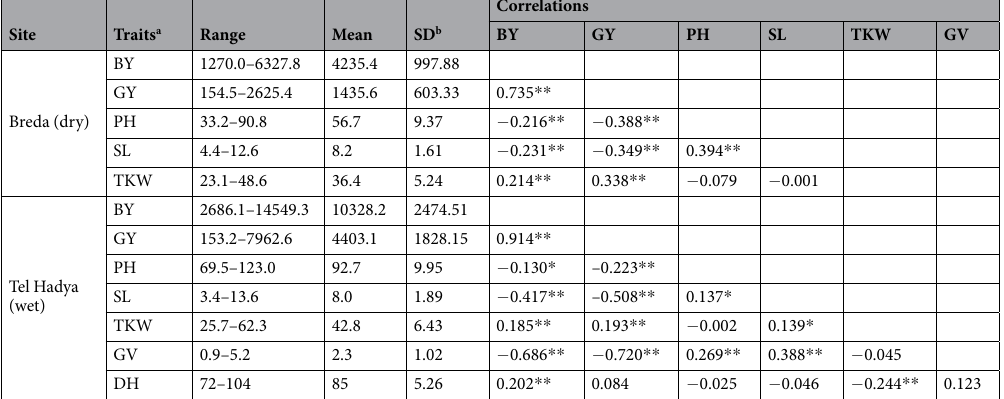
Table 5. Phenotypic scores from field trials for 227 barley accessions. a BY: total above ground biomass dry yield (kg/ha), DH: days to heading, GV: growth vigour (1 = good, 5 = bad), GY: grain yield (kg/ha), PH: height at the base of the spike (cm), SL: spike length (cm), TKW: thousand kernel weight (g). b SD: standard deviation. * Correlation is significant at the 0.05 level (2-tailed). ** Correlation is significant at the 0.01 level